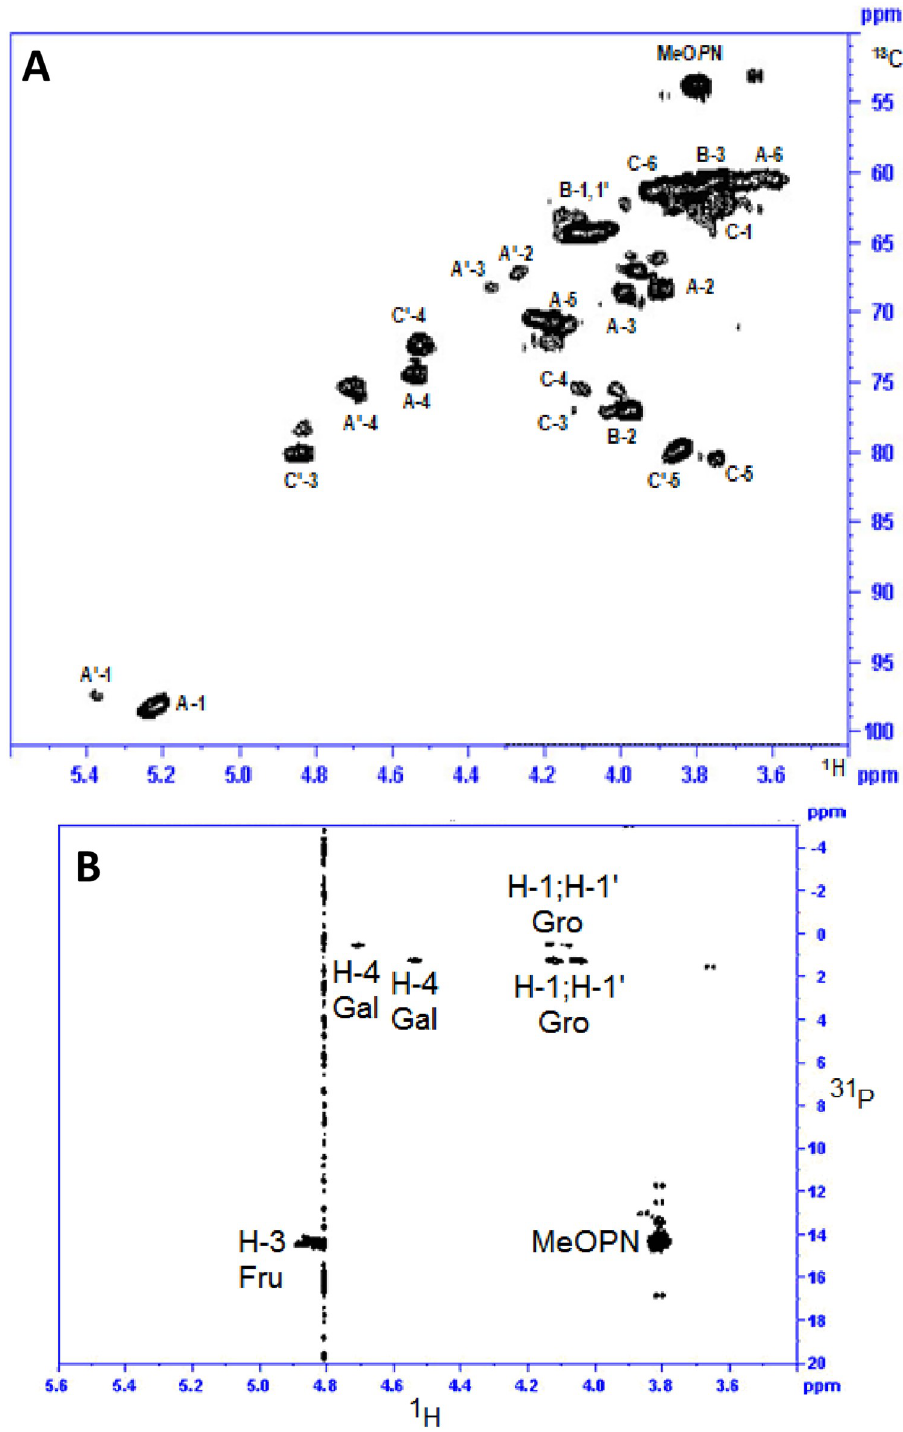
Fig 4. NMR of HS1/44 CPS. (A) 2D 1 H- 13 C HSQC spectrum of HS1/44 native CPS; (B) 2D 1 H- 31 P HMBC spectrum of HS1/44 native CPS.